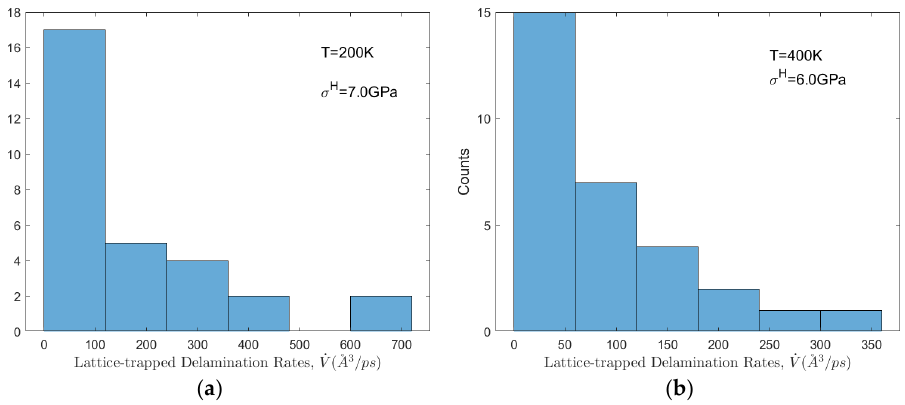
Figure 7. Histograms of lattice-trapped delamination rates from 30 replicas at ( a ) T = 200 K and 𝜎 𝐻 = 7.0 GPa and ( b ) T = 400 K and 𝜎 𝐻 = 6.0 GPa.